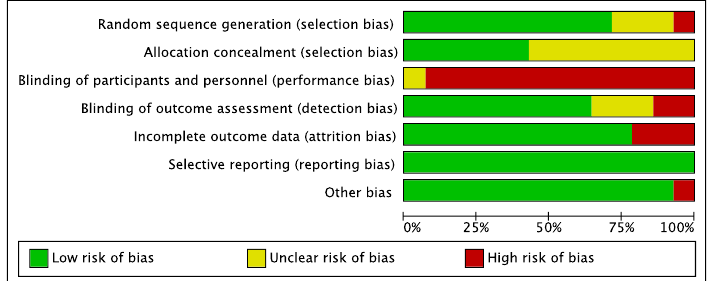
Figure 3. The distribution of the methodological quality of included studies.